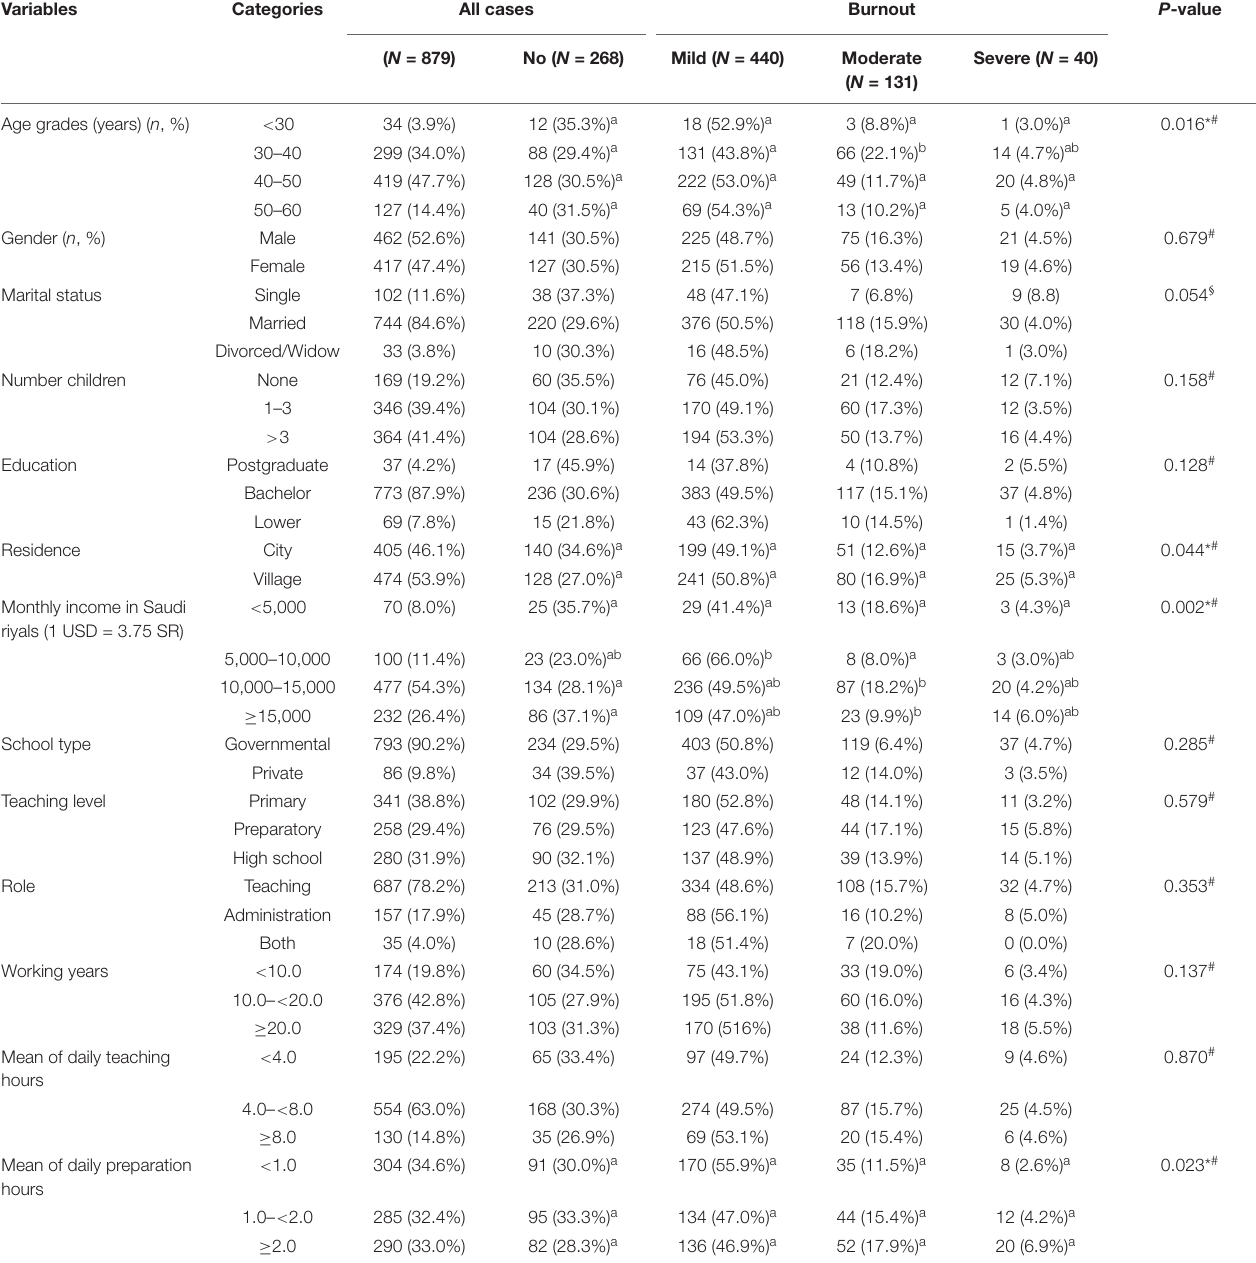
TABLE 1 | The general characteristics of study participants according to burnout risk factors ( N =